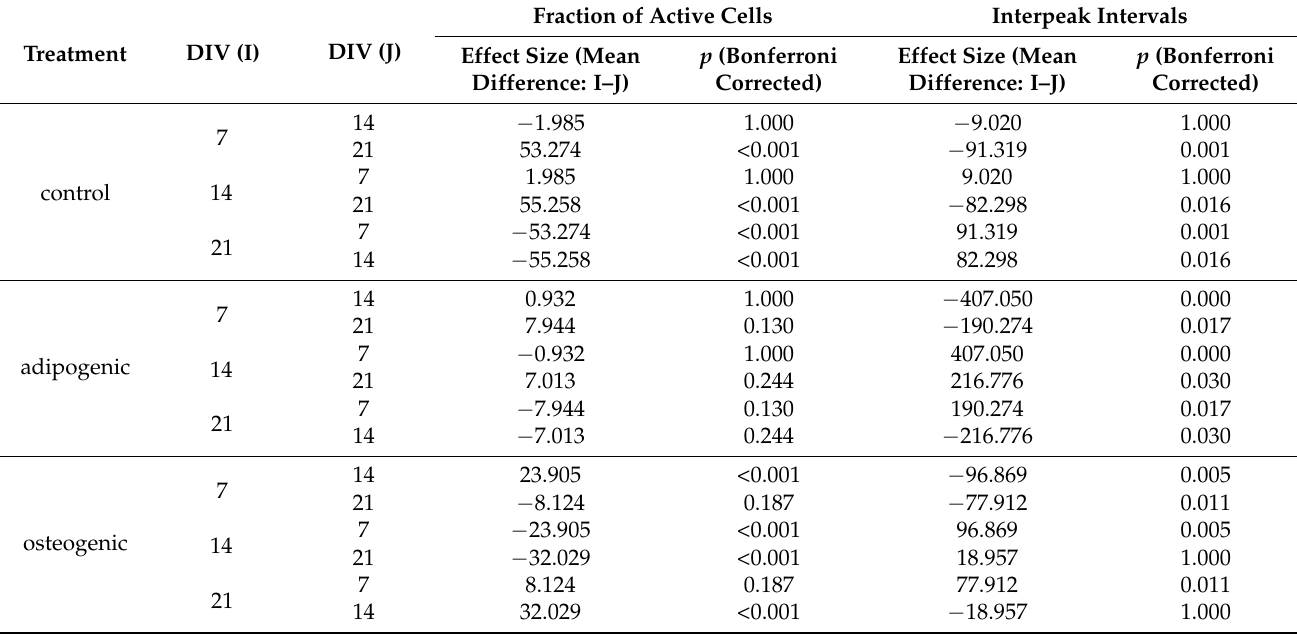
Table 1. Pairwise comparisons between timepoints within each treatment. p values have been calculated using unpaired Student’s t -tests with Bonferroni